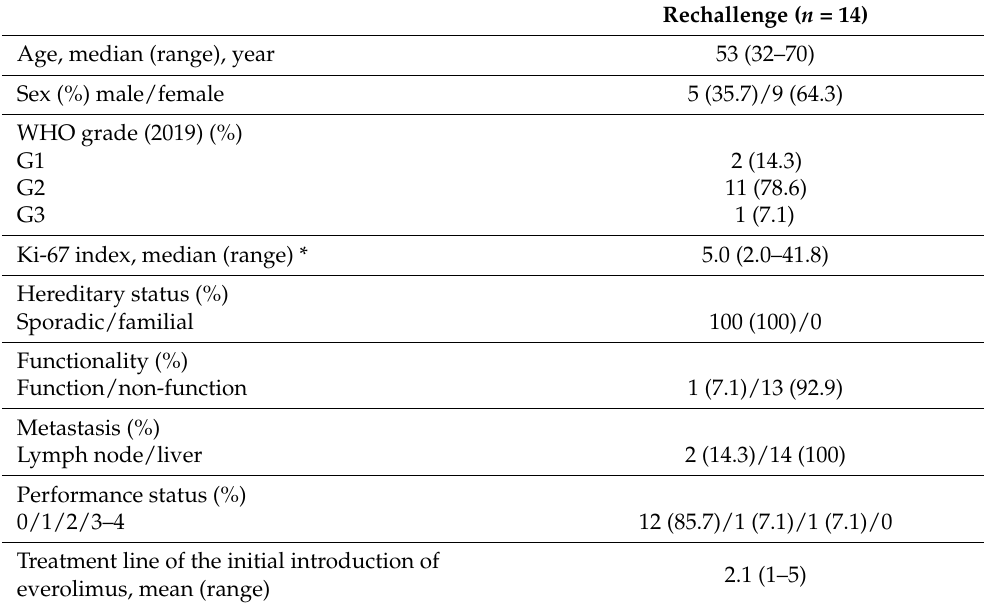
Table 1. Patients’ characteristics with everolimus